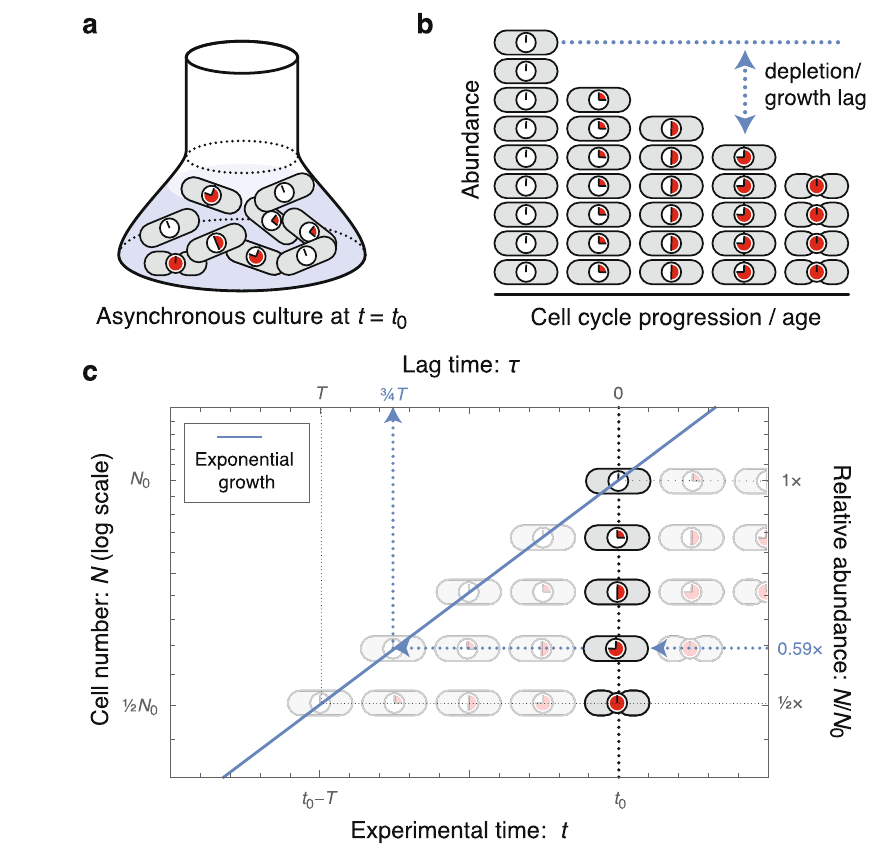
Fig. 1 | Lag-time analysis. a Sample preparation. An asynchronous culture in steady-state exponential growth is harvested at time t = t 0 . b Quantitation of demographics. Cell abundance is quanti fi ed. For analyzing replication dynamics, cell quantitation is performed by next-generation sequencing. c Measurement of lagtime.Thedottedblacklinerepresentsthecultureat t = t 0 .Cellswithgreatercell- cycleprogression(i.e.,age)aredepletedrelativetonewborncells.Foreachcellage, therelativeabundancedeterminesthelagtime.Theirabundanceisequivalenttoan